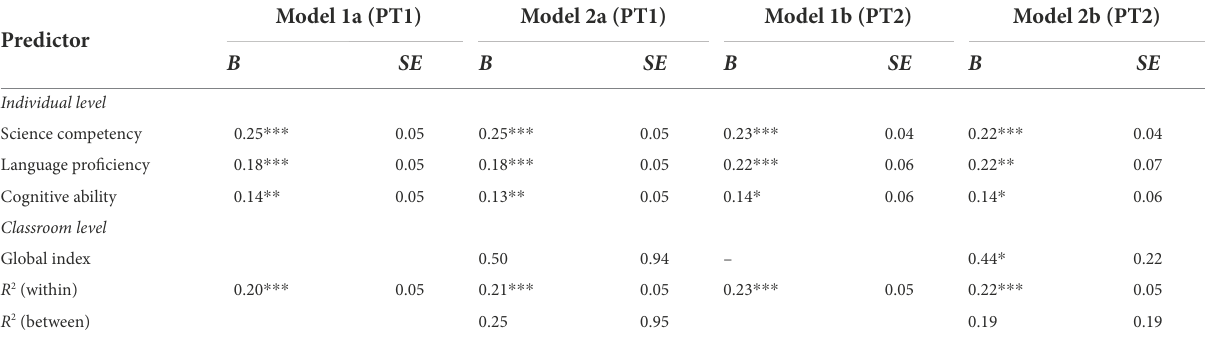
TABLE 4 Multilevel regression analyses predicting student performance on the posttests from individual-level variables and global index of adaptive classroom discourse.